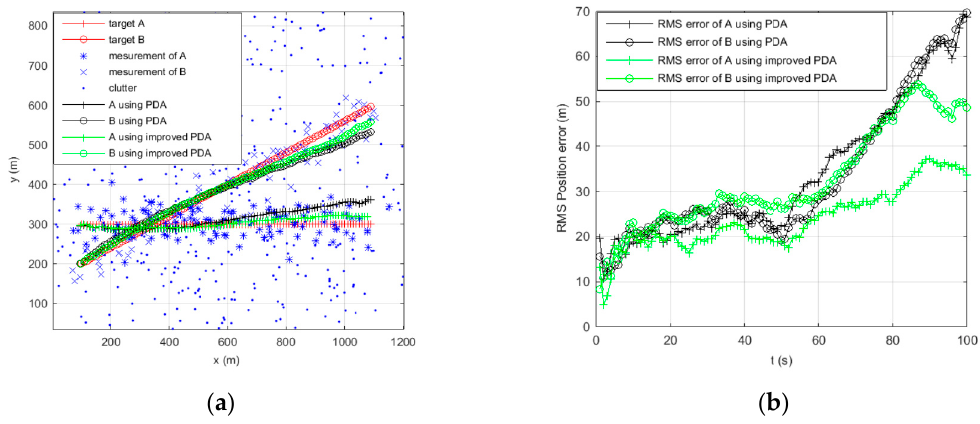
Figure 4. Tracking two crossing targets using PDA and improved PDA when clutter λ = 1. ( a ) Tracking of the target position; and ( b ) RMS position error of the target.